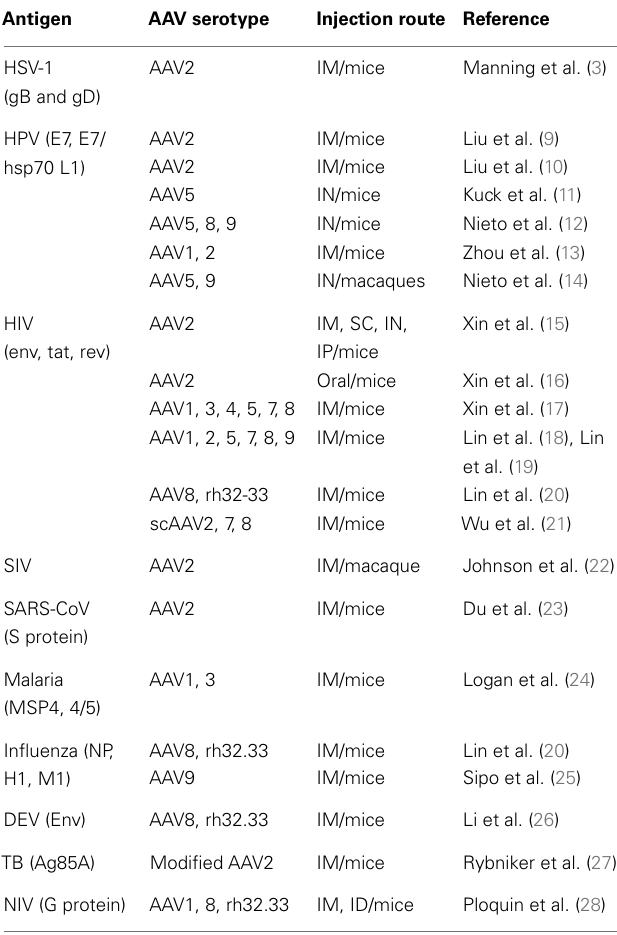
Table 1 | Summary of active immunization studies usingAAV vectors